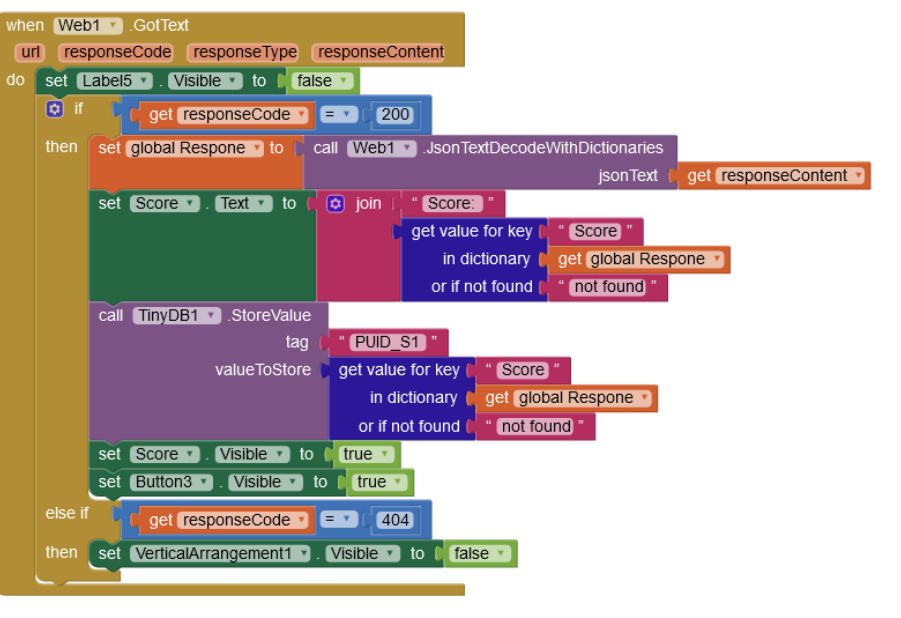
Figure 5. In this block, the application reads the web response and stores it in the phone’s memory, where it can be uploaded later. The simplicity of block-based coding makes it available for use and editing without the need for a skilled